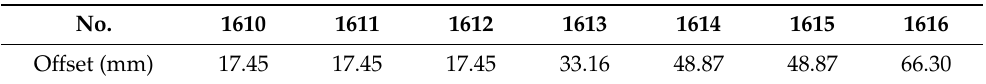
Table 1. Offset of each measuring point of the tower crane after completing work (17:00, 14 April 2021). No. 1610